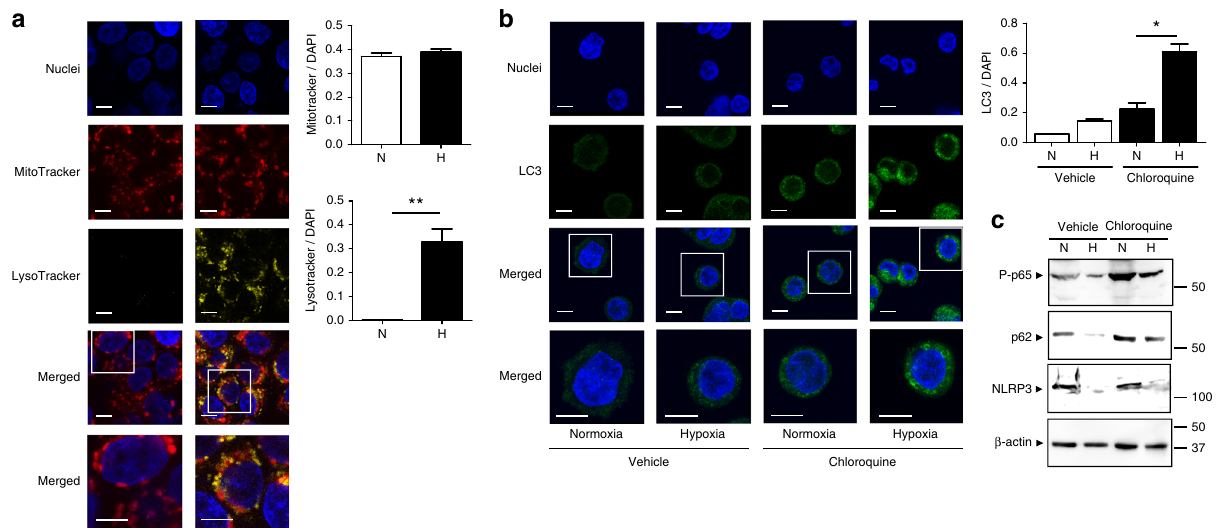
Fig. 5 Hypoxia reduces NF- κ B activation through the activation of autophagy. a HT-29 cells were subjected to hypoxia (0.2% O 2 , 24 h) and stained with DAPI ( blue ), as well as LysoTracker Yellow-HCK-123 ( yellow ) or MitoTracker Deep Red FM ( red ) to monitor lysosomal accumulation and functional mitochondria, respectively. Examples of cells containing both markers are presented in the magni fi ed insets. Scale bar, 10 µ m. Changes in lysosomal accumulation and functional mitochondria were calculated relative to DAPI staining from at least 10 areas of interest pooled from three independent experiments by two independent, blinded investigators. Statistical analysis was performed using Student t -test. Results represent mean + s.e.m., ** P < 0.01. b HT-29 cells were subjected to normoxia (21% O 2 ) or hypoxia (0.2% O 2 ) for 24 h in the presence or absence of 40 µ M chloroquine. Cells were stained for LC3 ( green ) or cell nuclei (DAPI ( blue )). Examples of cells containing both markers are presented in the magni fi ed insets. Scale bars, 10 µ m. Changes in LC3 accumulation were calculated relative to DAPI staining from at least 10 areas of interest pooled from four independet experiments. Statistical analysis was performed using one-way ANOVA followed by Tukey ’ s post-test. Results represent mean + s.e.m., * P < 0.05. c LPS-treated HT-29 cells were subjected to normoxia (21% O 2 ) or hypoxia (0.2% O 2 ) for 24 h in the presence or absence of 40 µ M chloroquine. Results are representative of two